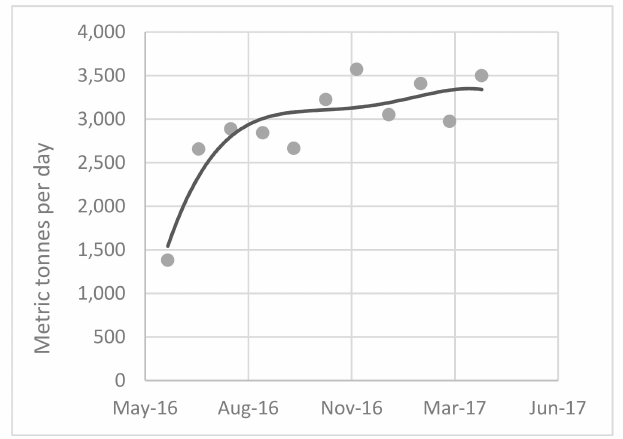
Figure 5. Feed tonnage to ore sorting plant during ramp-up phase of an XRT-based ore sorting plant at San Rafael Mine